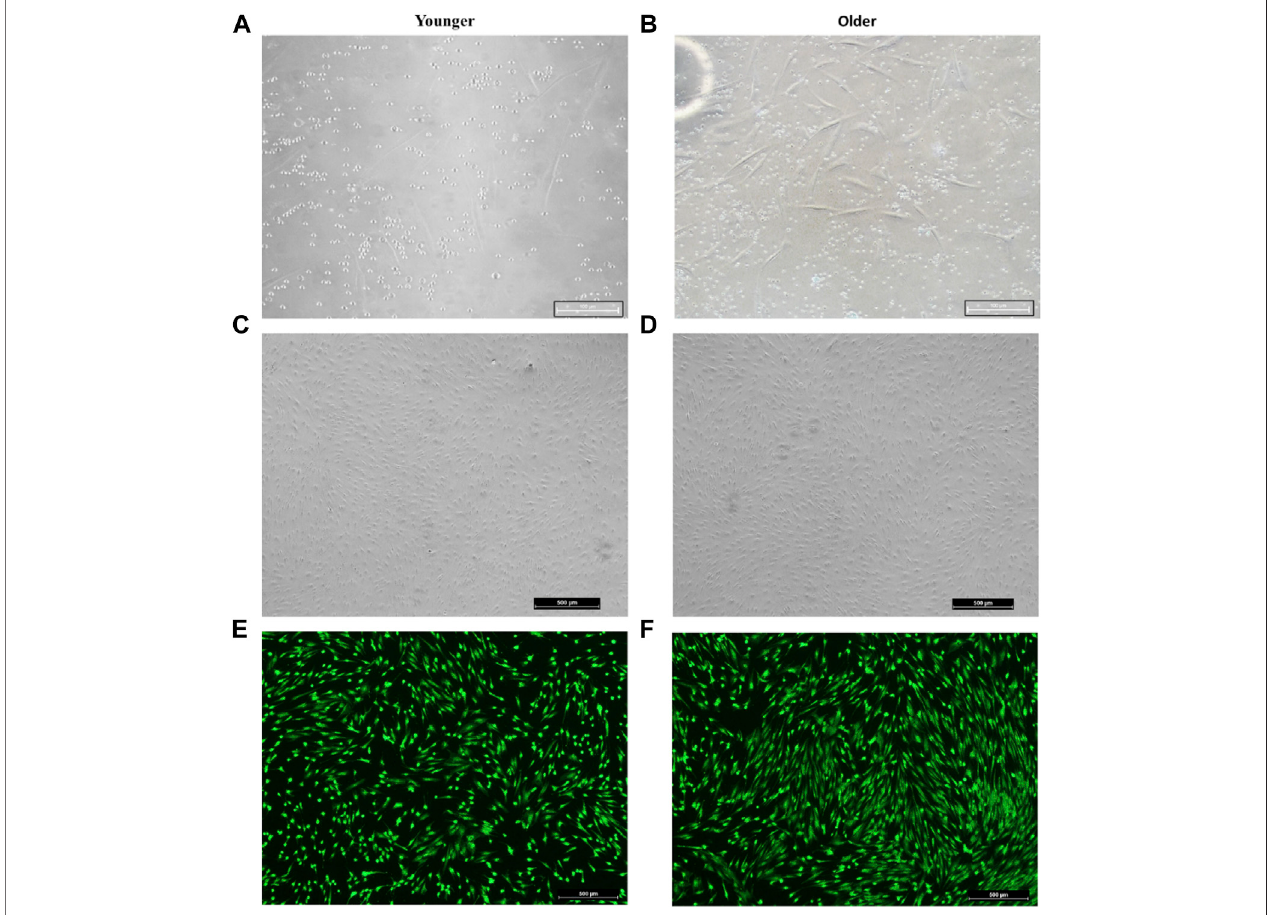
FIGURE2| Representativeimageof (A,C,E) younger and (B,D,F) olderMSCsfromclotted BMA. (A,B) MSCsfromclotted BMAat6days ofculture; thepresence of some red blood cells, platelets, and leucocytes. Magni fi cation × 20. (C,D) MSCs from clotted BMA at 20 days of culture; the homogenous population of spindle-shaped and plastic-adherent cells. Magni fi cation × 4. (E,F) Live/Dead analyses at 20 days of culture; green staining: viable cells; red staining: dead